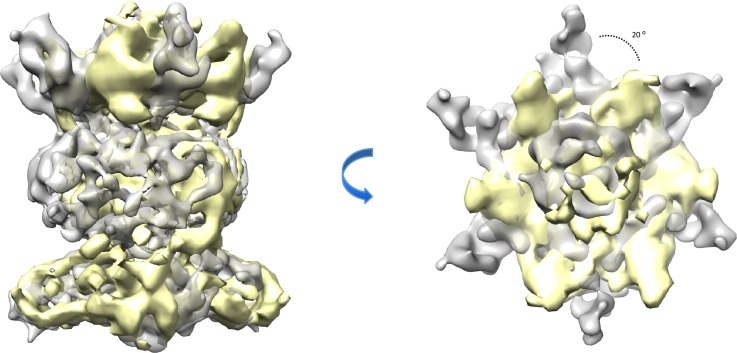
Comparison of the abMlaBDEF and ecMalBDEF complex.The map of abMlaBDEF (this study) is shown in grey, overlaid to that of ecMlaBDEF (Ekiert et al., 2017) in yellow, aligned in the cytosolic domains density. The overall architecture of both complexes are similar, however MlaD appears offset by ~20 O in the A. baumannii complex, compared to the E.coli complex. It remains to be determined if this corresponds to a difference between species, or if the two structures were obtained in different states of substrate binding and/or nucleotide hydrolysis.